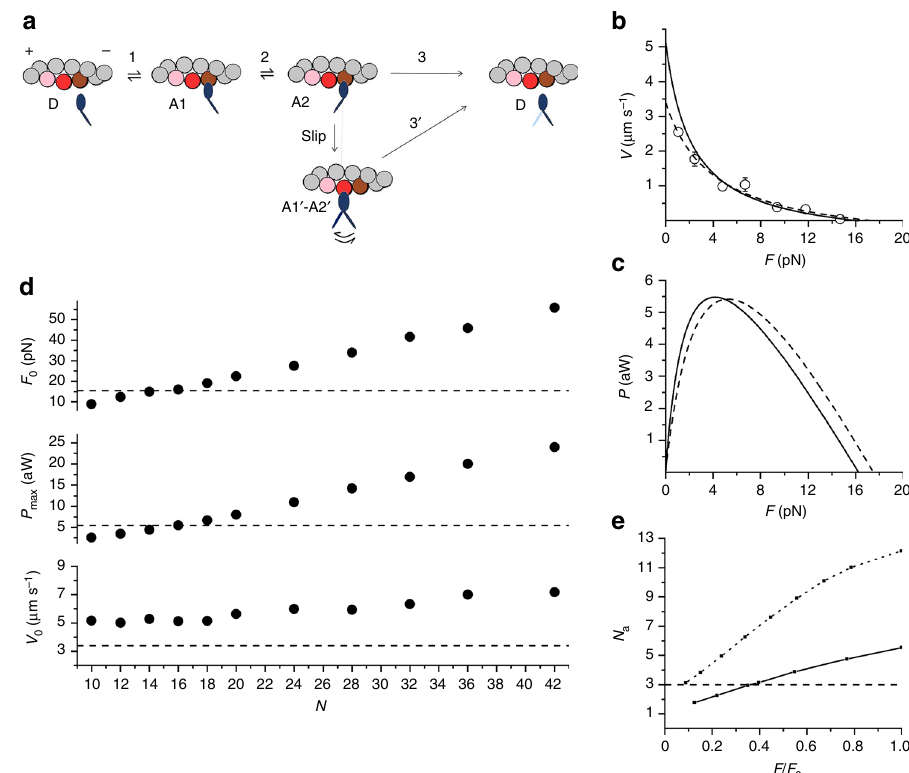
Fig. 4 Model simulation of the mechanical output of the machine. a Kinetic scheme, with three states of the myosin head (blue): D, detached; A1 and A2, attached to one monomer of the actin fi lament (brown). The scheme includes the possibility that during shortening the attached head in the A2 state slips to the next actin monomer farther from the centre of the sarcomere (red). The probability of a second slipping to the pink monomer is limited to 1/10 of that of the fi rst slipping. Details on the strain dependence of the rate functions and how they are constrained by fi tting skeletal muscle performance are in Supplementary Fig. 6. The corresponding equations are listed in Supplementary Table 1. The effect of trap compliance on the nanomachine performance is detailed in Supplementary Fig. 7. b F – V relation calculated for a number of available heads, N = 16 (continuous line) and experimental relation from Fig. 2e (open circles and dashed line). c Corresponding P – F relations. d Dependence on N of the three parameters featuring the machine performance, as indicated in the ordinate of each plot. The dashed lines are the respective experimental values. e Relation between number of attached heads ( N a ) and force relative to F 0 calculated with the model for N = 16 (continuous line) and 32 (dotted